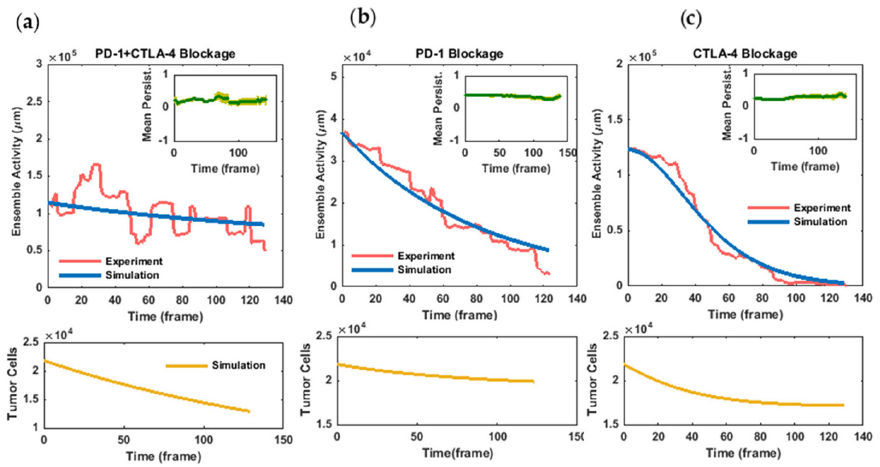
Figure 4. Temporal variation in immune cell activity and dynamical model simulation in (a) com- bined as well as individual blockade of (b) PD-1 and (c) CTLA-4 pathways . Immune cell